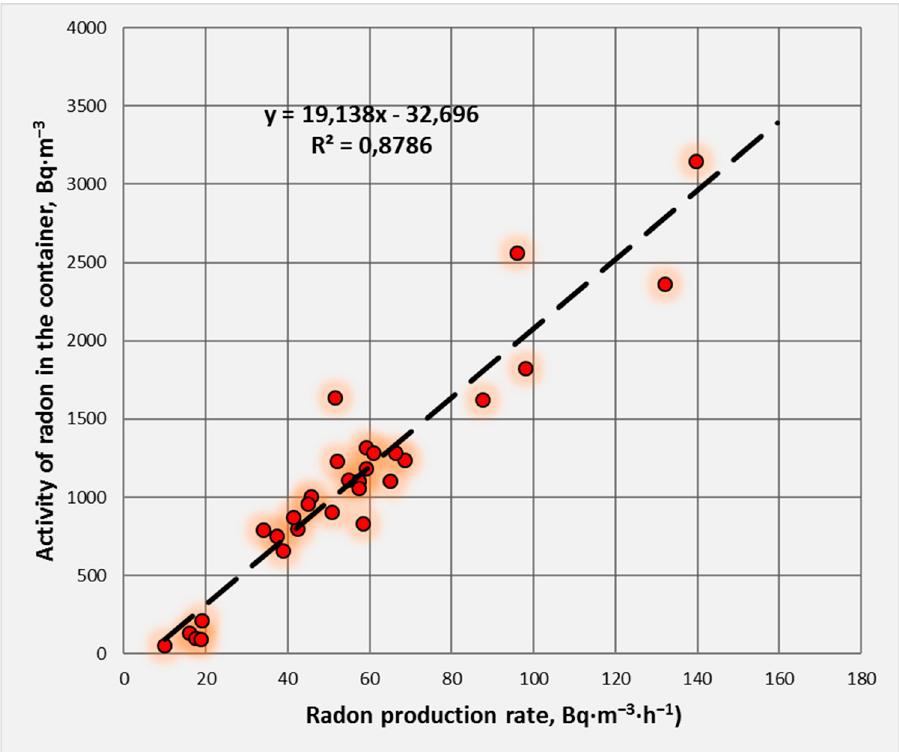
Figure 7. Regression model of the relationship between the volumetric activity of radon and the level of radon production.